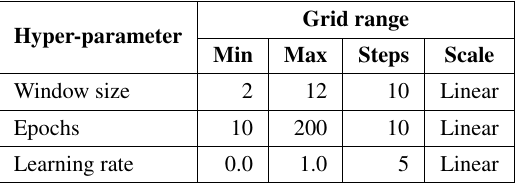
Table 1. Grid search based hyper-parameter optimization configuration